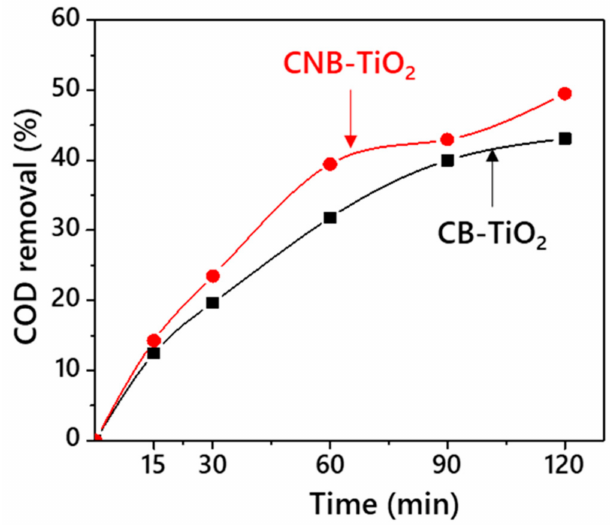
Figure 8. Comparative performance of CB-TiO 2 and CNB-TiO 2 for COD removal from the